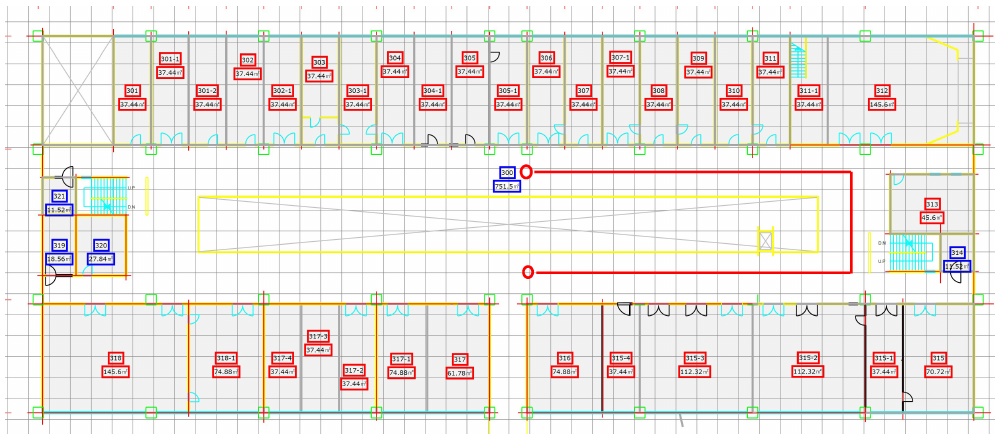
Figure 13. The test path on EE building floor 3.